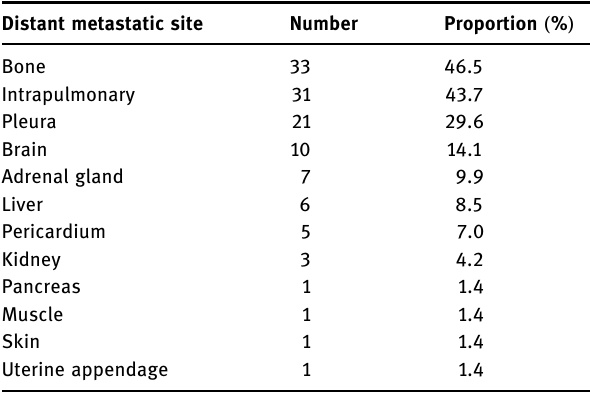
Table 2: Metastases of young patients at stage IV ( n = 71 )